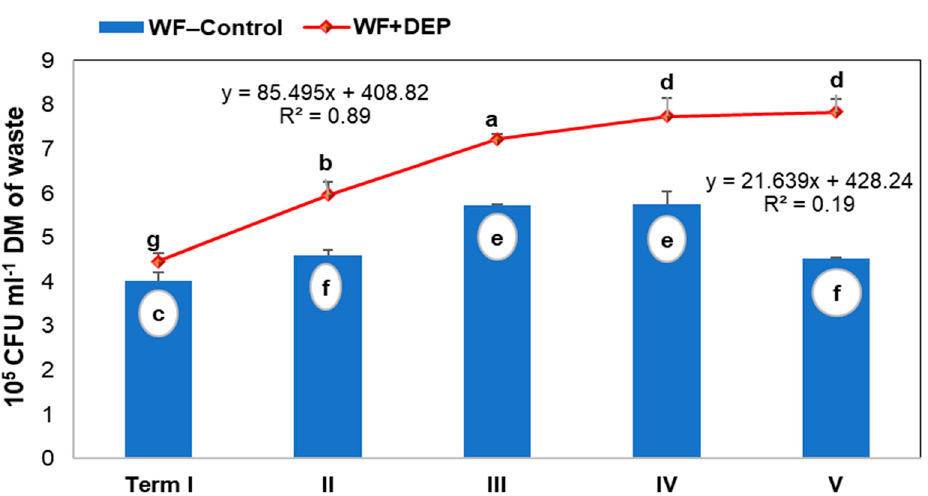
Figure 3. Bacteria total count changes found in the digested sampled material. Explanation: The same letter indicates a lack of significant differences ( p < 0.05).